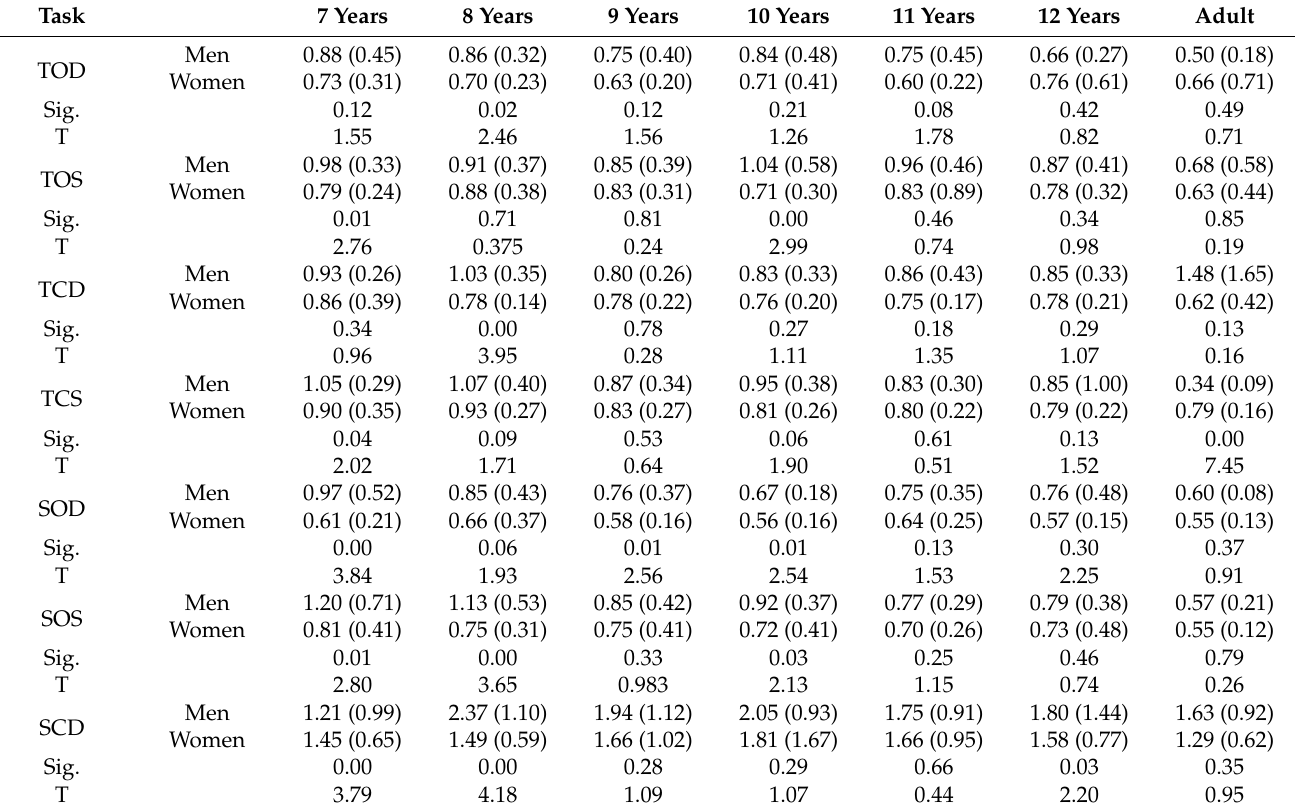
Table 3. Comparison of male and female participants regarding PS in the ML